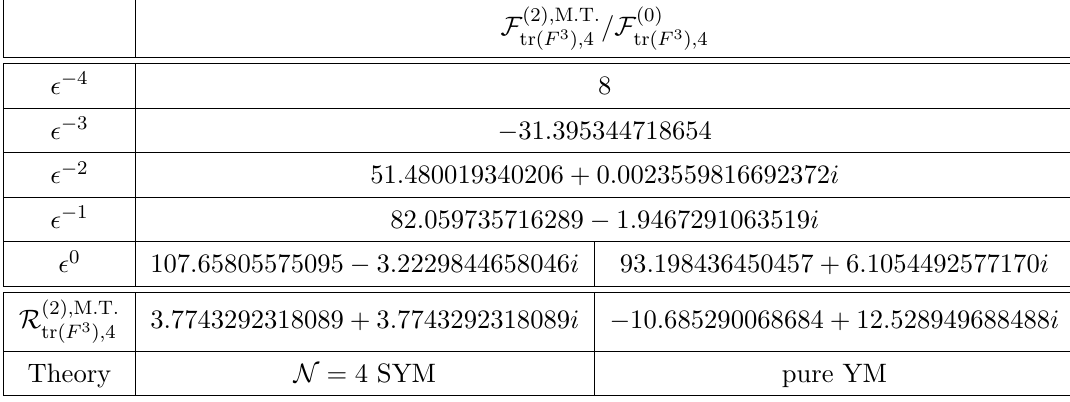
Table 7. The numerical results of the two-loop four-point form factors in the two theories up to finite order, and the finite remainders are given in the last line, where the kinematics are chosen as: { q 2 = 13 , s = 9 / 2 , s = 67 / 10 , s = 10 , s = 17 / 2 , s = 38 / 5 , s = 91 / 10 and 12 23 34 14 13 24 − − − − − tr = 3 √ 10195351 / 100 i 5